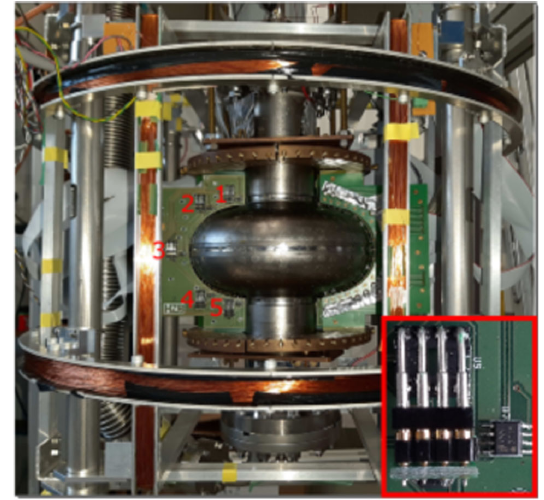
FIG. 2. Setup with cavity, Helmholtz coils, magnetic field mapping card mounted on the left-hand side of the cavity, and temperature mapping card mounted on the right-hand side of the cavity. The AMR sensor groups are labeled from one to five and an enlarged picture of an AMR sensor group is added in the bottom right corner. The sensor measuring in z can be seen on the right, the sensor measuring in ρ is hidden below the adapter of the sensor measuring in θ which is visible at the very